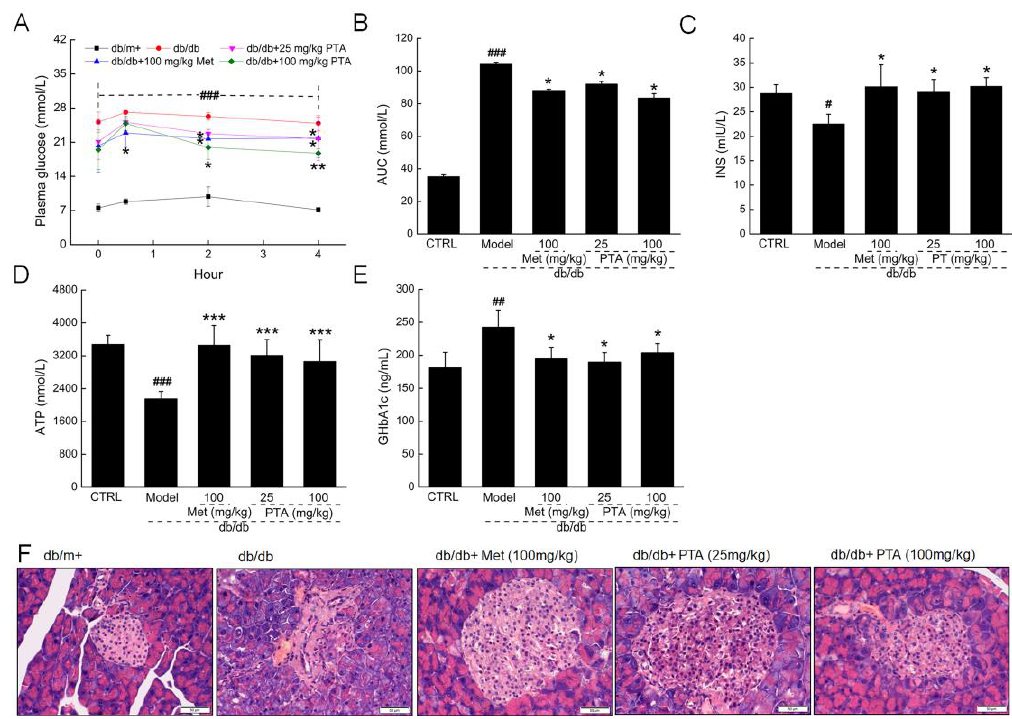
Figure 2. The hypoglycemic effects of PTA on db/db mice. Blood glucose levels ( A ) and the values of area under the curve (AUC) ( B ) within 4 h after glucose administration. ELISA detection of insulin ( C ), ATP ( D ), and glycosylated hemoglobin A1c (GHbA1c ( E ) levels in the sera of db/db mice. Data are expressed as means ± SD (n = 12). # p < 0.05, ## p < 0.01 and ### p < 0.001 vs. C57BLKS/J-LepR db/+ (db/m + ) mice, * p < 0.05, ** p < 0.01 and *** p < 0.001 vs. non-treated db/db mice. ( F ) Histopathological analysis of pancreatic islets via hematoxylin and eosin (H and E) staining (scale bar: 50 μm; magnification: 200×) (n = 6).